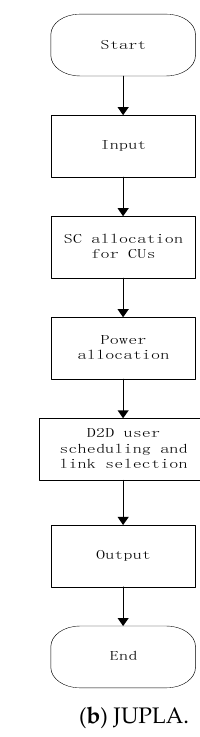
Figure 6. Flow chart of the exhaustive search algorithm and the joint user scheduling, tree-based search power allocation and distance-aware link selection algorithm. ( a ) Flow chart of the exhaustive search algorithm (ESA). ( b ) Flow chart of the joint user scheduling, power allocation and link selection algorithm (JUPLA).